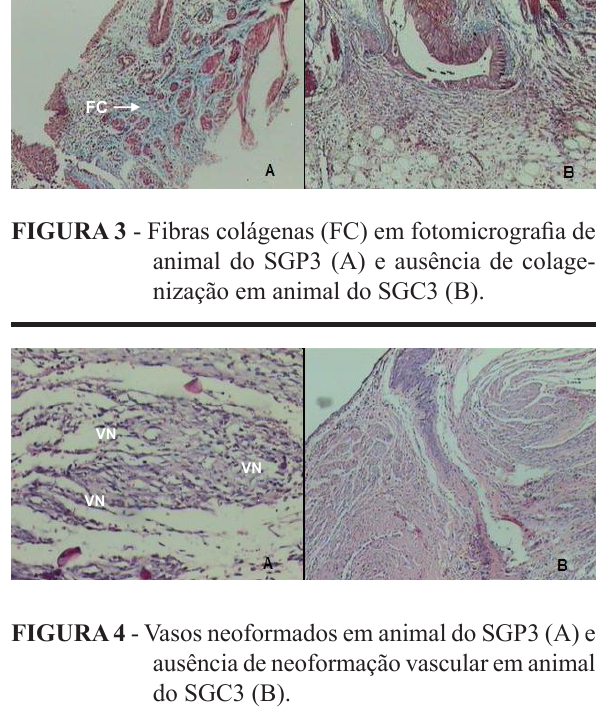
FIGURA 4 - Vasos neoformados em animal do SGP3 (A) e ausência de neoformação vascular em animal